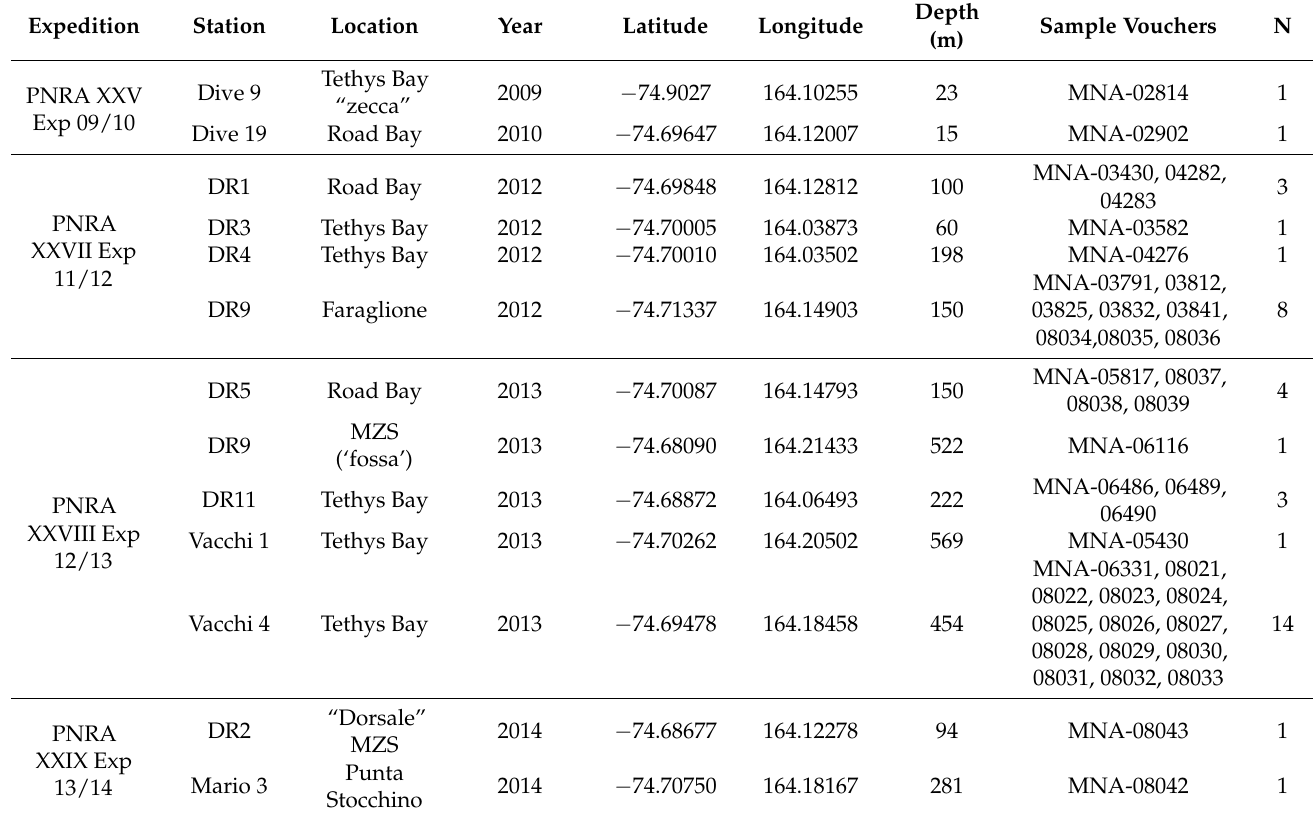
Table 1. Sampling stations and data. Abbreviations: Mario Zucchelli Station (MZS); number of specimens ( n